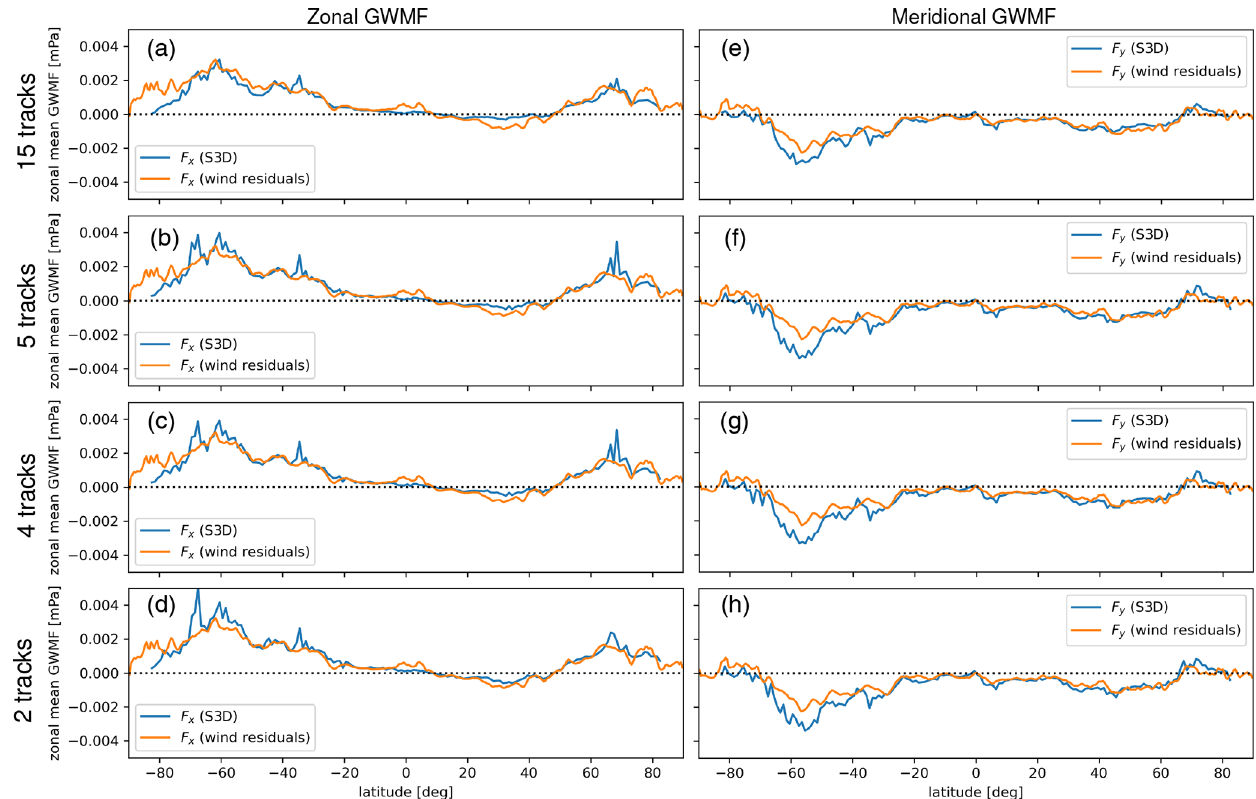
Figure 16. Same as for Fig. 14 but for an altitude of